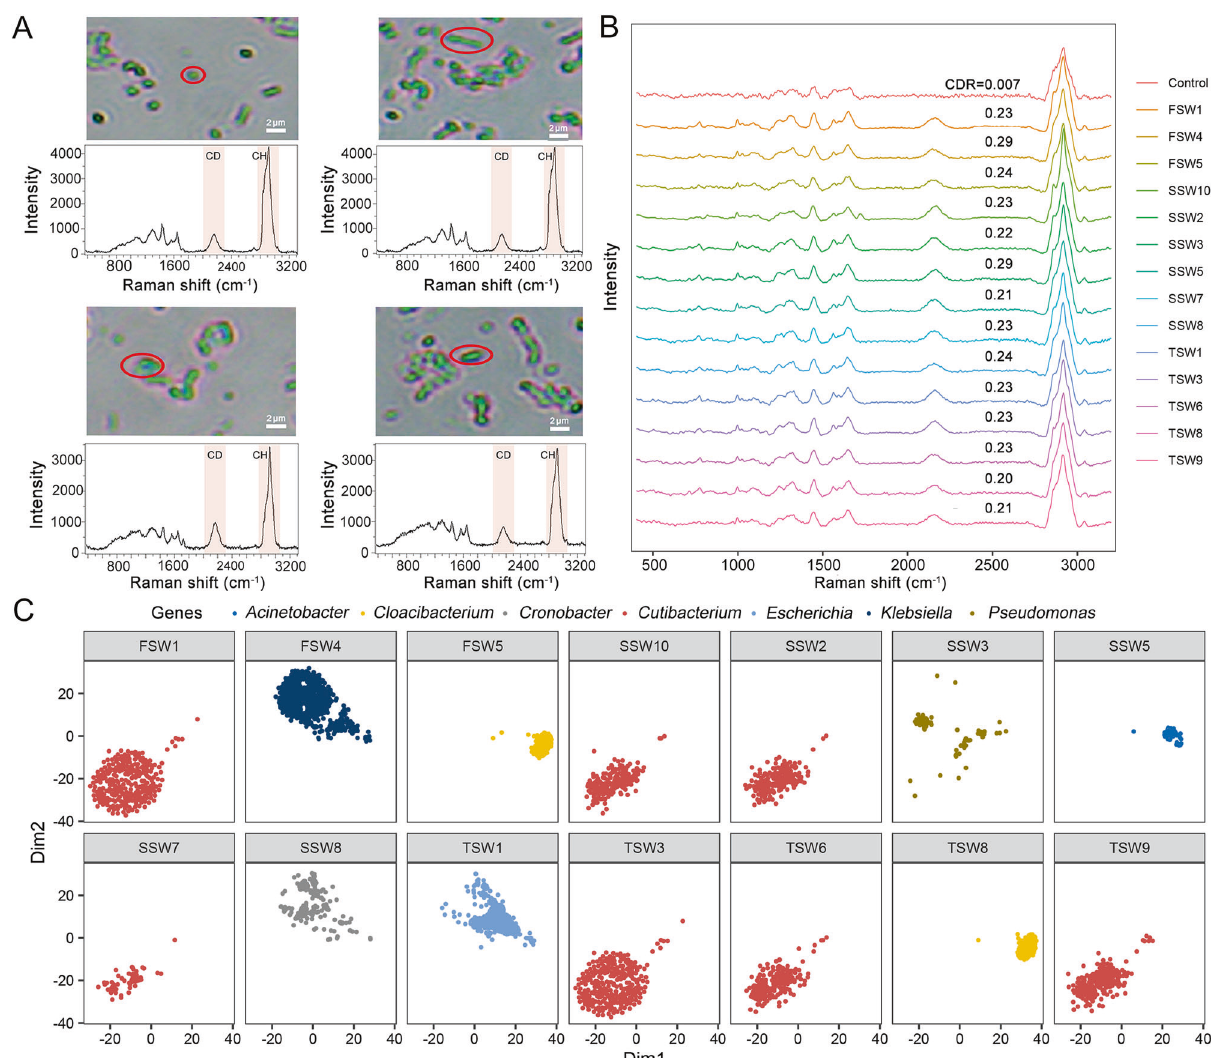
Fig. 6 One-cell RACS-Seq of metabolically active organic-PSM cells from sewage. A Organic-PSM cells, with varying morphological features, as identi fi ed in the sewage based on SCRS. B SCRS of the C-D band-containing cells, which were treated with D 2 O for 24 h and sorted via the threshold of CDR > 0.20 for single-cell genomes. SCRS of ‘ FSW1, FSW4, FSW5, SSW2, SSW3, SSW5, SSW7, SSW8, SSW10, TSW1, TSW3, TSW6, TSW8 and TSW9 ’ represent cells with the C-D band. SCRS of ‘ control ’ correspond to cells without CD band. CDR = Area (C-D)/(Area(C-D) + Area(C-H)). C Taxonomical origin of the one-cell scRACS-Seq derived organic-PSM genomes based on the t-SNE projection of binned contigs. Contigs are visualized based on 4-mer frequency features. Each contig is colored based on its taxonomic annotation at the family